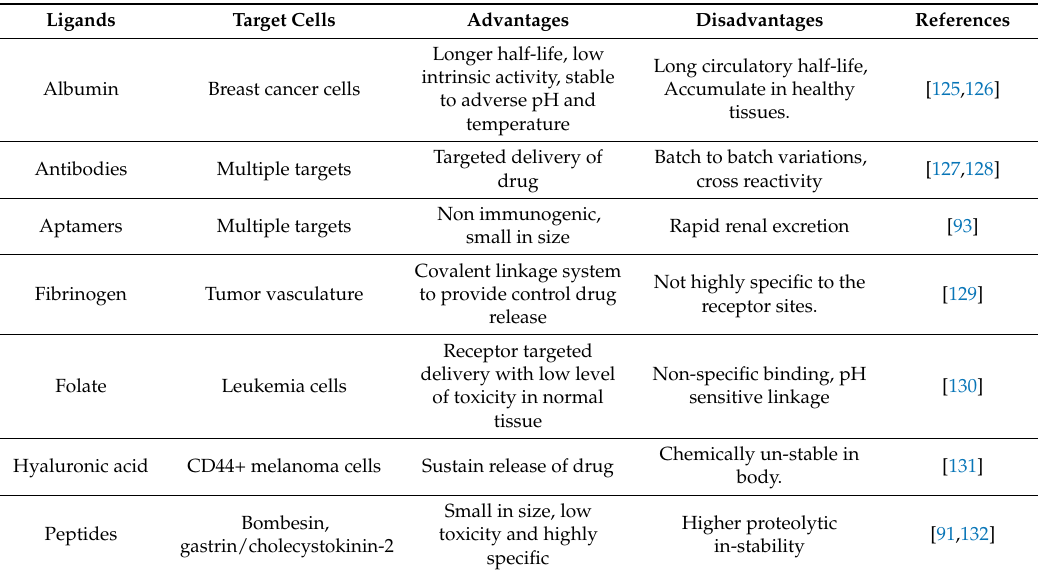
Table 4. Examples of targeting ligands that have a potential to bind with radioisotopes for diagnostic and therapeutic